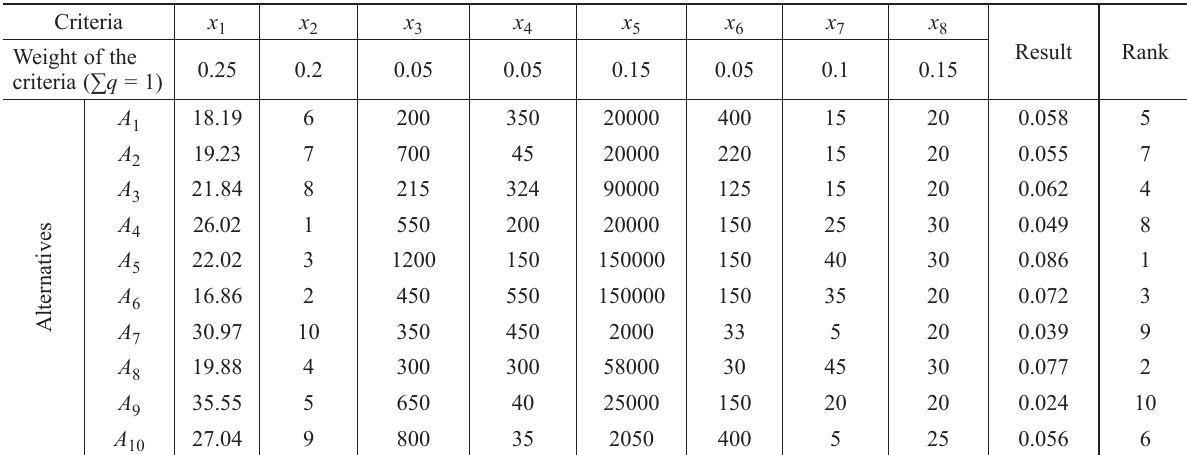
Table 4. The decision matrix of the final data obtained following the Laplace rule Criteria